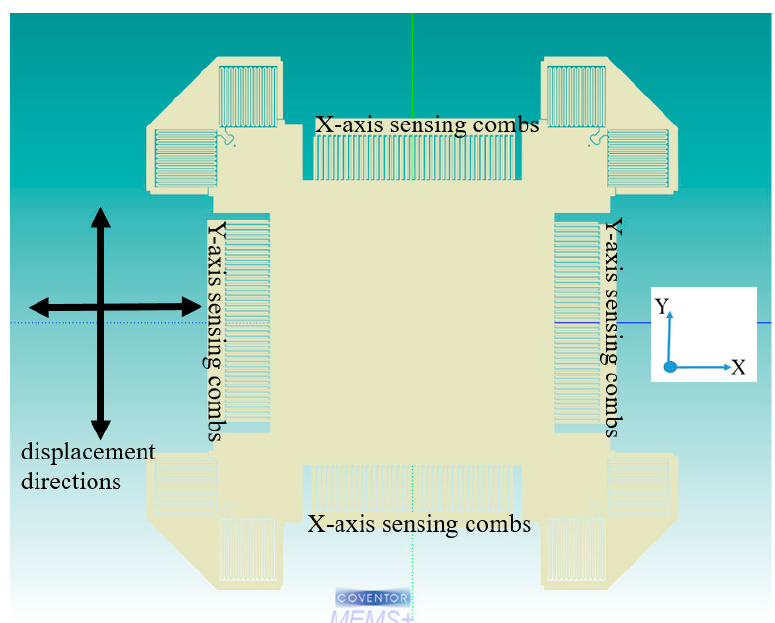
Figure 5. Dual axis gap change differential accelerometer.